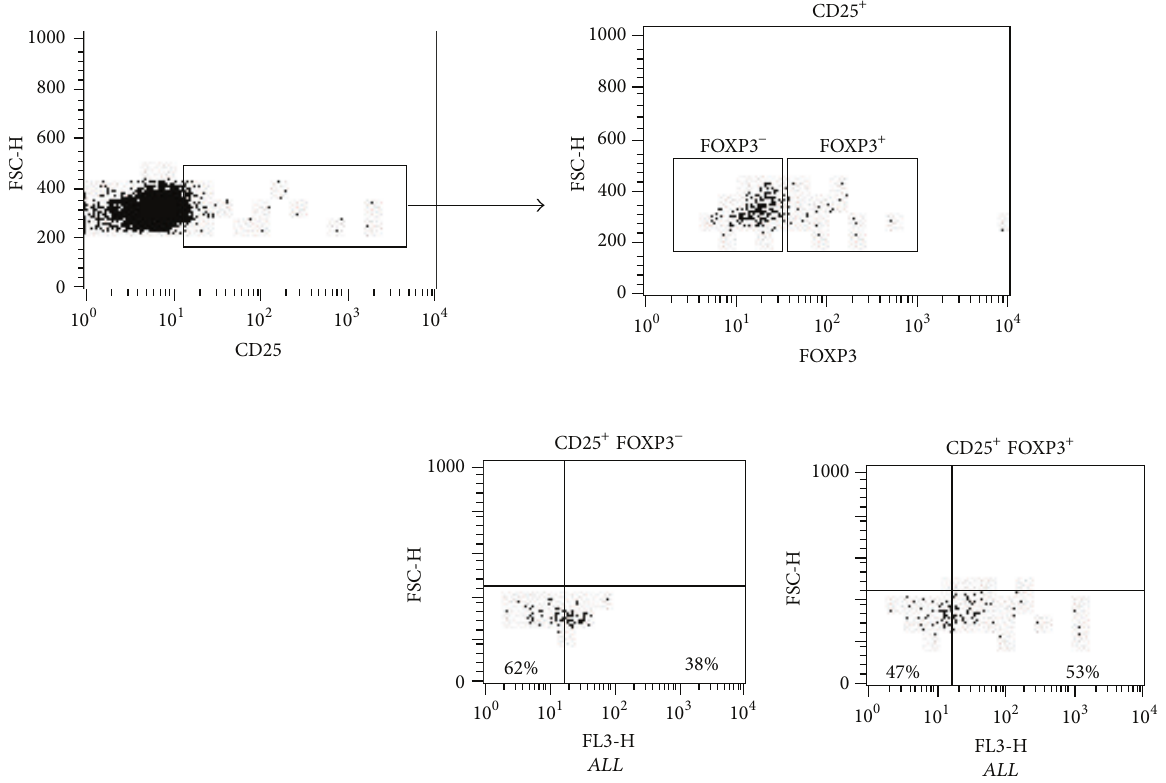
Figure 3: CD25 and Foxp3 frequency on ALL − and ALL + CD4 + T cells. To analyze cell surface marker staining, a gate was drawn around the lymphocyte population based on their physical characteristics (forward) and positive fluorescence to CD25; a second gate was drawn based on positive or negative fluorescence to Foxp3. CD25 + cells positive or negative to Foxp3 were analyzed by binding to ALL .